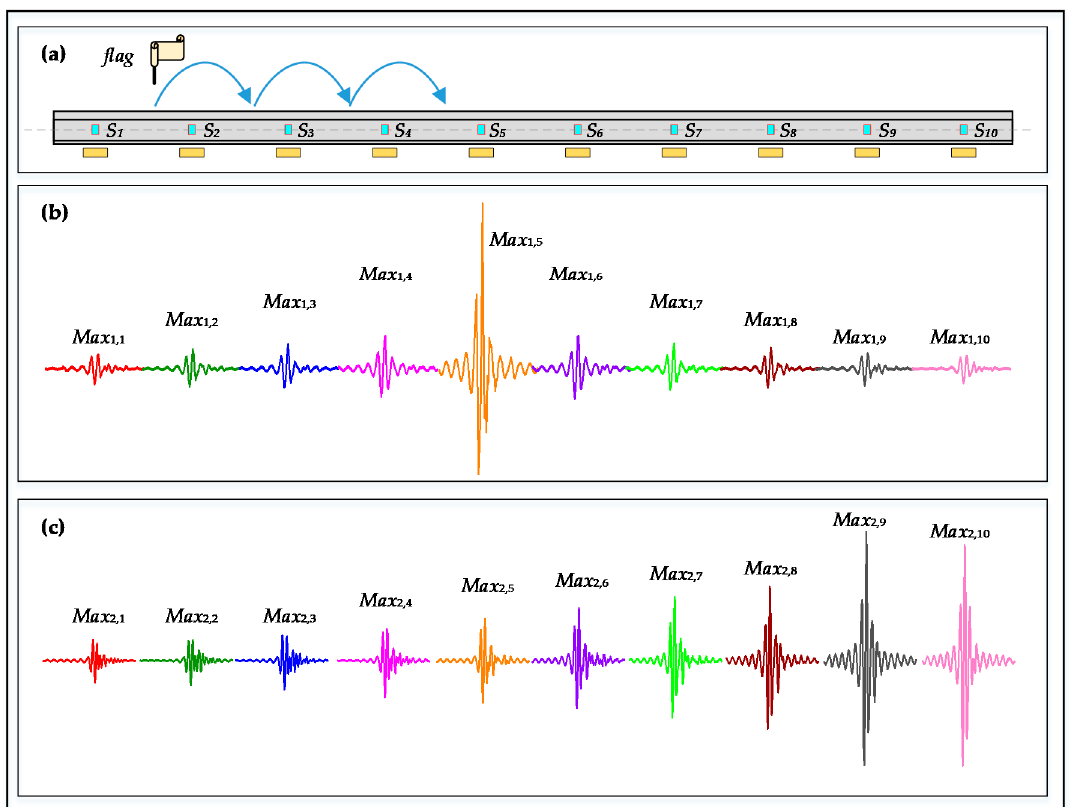
Figure 19. The relationship of response amplitudes and sensor location: ( a ) Movement rule of the parameter flag; ( b ) filtered signals during IMP 1 (0.1875~0.225 s); and ( c ) filtered signals during IMP 2 (0.325~0.35 s).